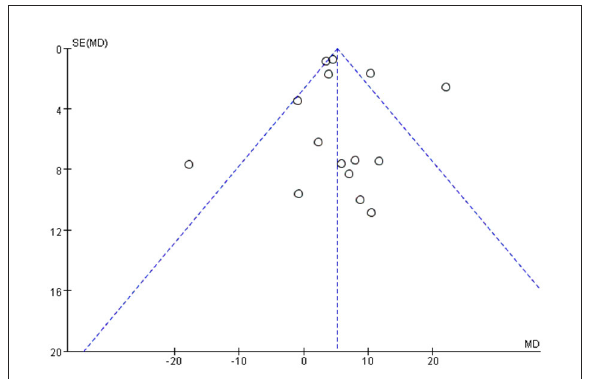
FIGURE10 Funnel chart of step cadence for meta-analysis.